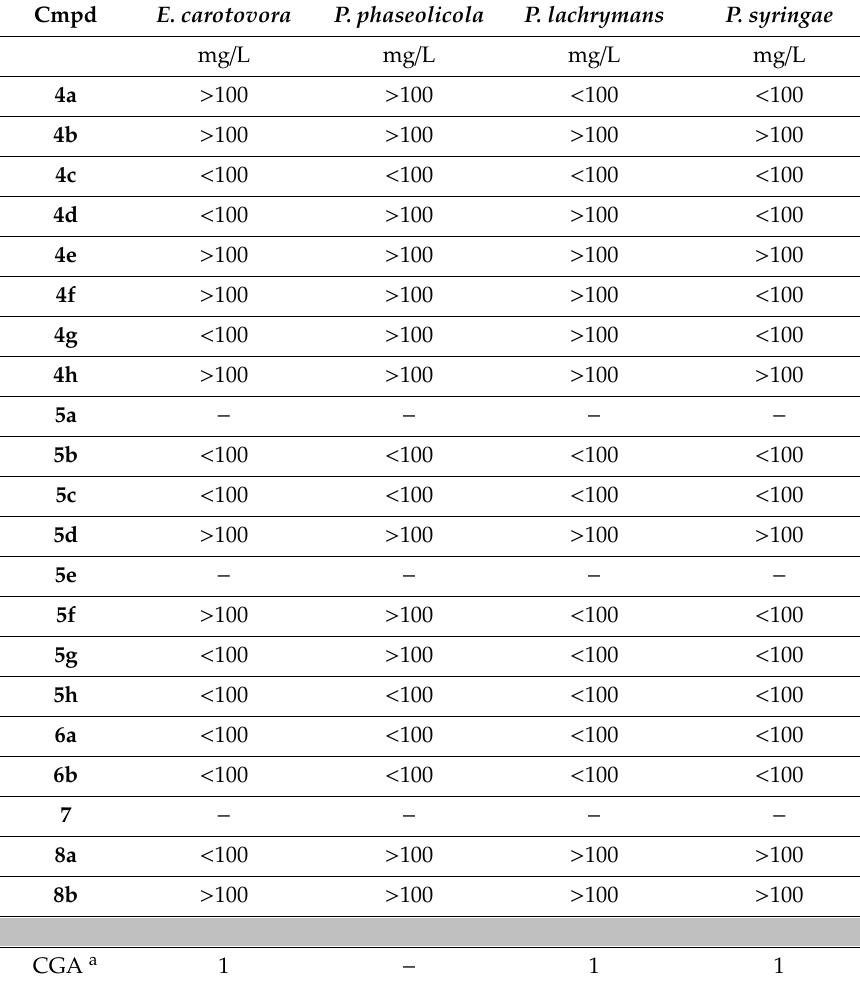
Table 3. Bacteriostatic activity MIC of selenoureas 4 – 8 at 100 mg / L. Cmpd